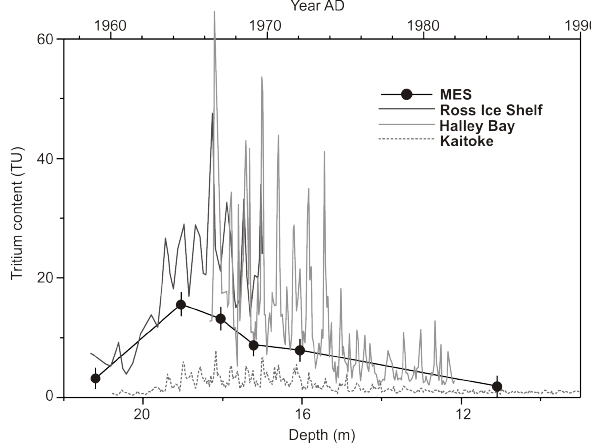
Fig. 2. Tritium contents of six MES ice core samples plotted with tritium contents of precipitation from the Ross Ice Shelf, Halley Bay, Antarctic Peninsula, and Kaitoke, New Zealand, decay-corrected to December 2006. Error bars are 1 σ . The detection limit for analysis without prior enrichment is 2.5 TU. One tritium unit (TU) is defined as one atom of tritium per 10 18 atoms of hydrogen, equivalent to 0.118 becquerels (Bq) per litre of water.